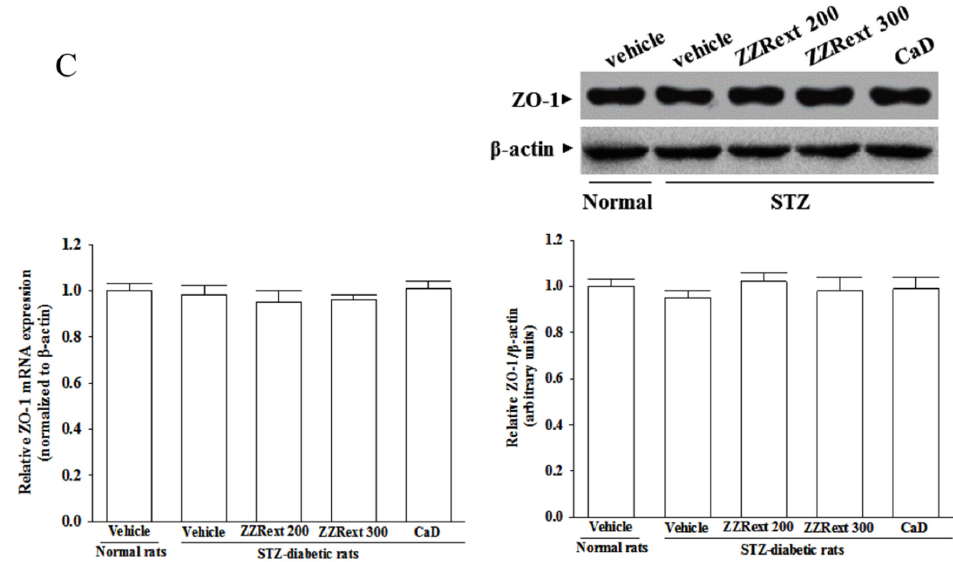
Figure 2. Effects of treatments on the mRNA and protein levels of ( A ) occludin, ( B ) claudin-5, and ( C ) ZO-1 in retina of rats. STZ-diabetic rats (STZ) were administered 200 mg/kg/day ZZRext (ZZRext 200), 300 mg/kg/day ZZRext (ZZRext 300) or 500 mg/kg calcium dobesilate (CaD) by oral gavage once daily for three months. Another group of STZ-diabetic rats and normal rats (normal) were administered the same volume of vehicle. Data are mean ± S.D. (standard deviation) from eight rats per group, and the experiments were repeated independently at least three times with similar results. * p < 0.05 compared to the values of vehicle-treated normal rats. # p < 0.05 compared to the values of vehicle-treated STZ-diabetic rats.